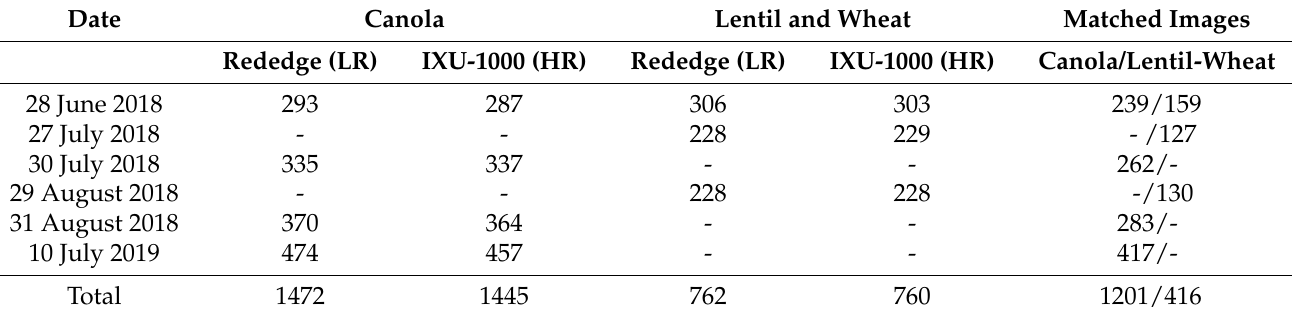
Table 1. The number of images captured by each sensor and the number of matched images for different acquisition dates. Canola Lentil and Wheat Matched